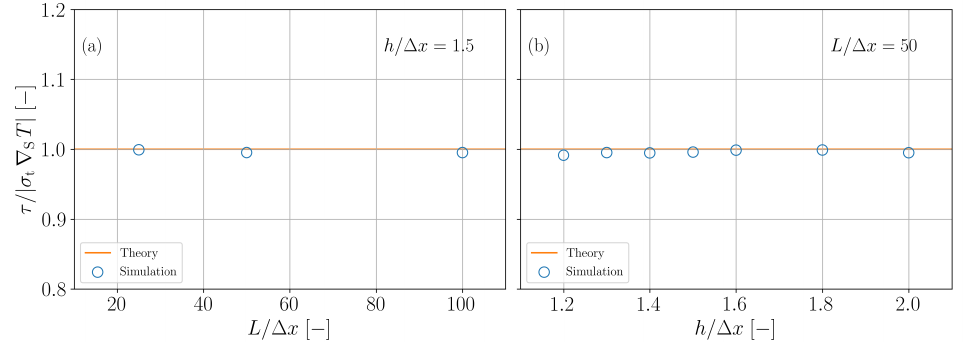
Figure 19. Tangential surface tension induced by temperature gradient. Normalized tension as a function of the spatial resolution ( a ) and as a function of the normalized smoothing length ( b ).